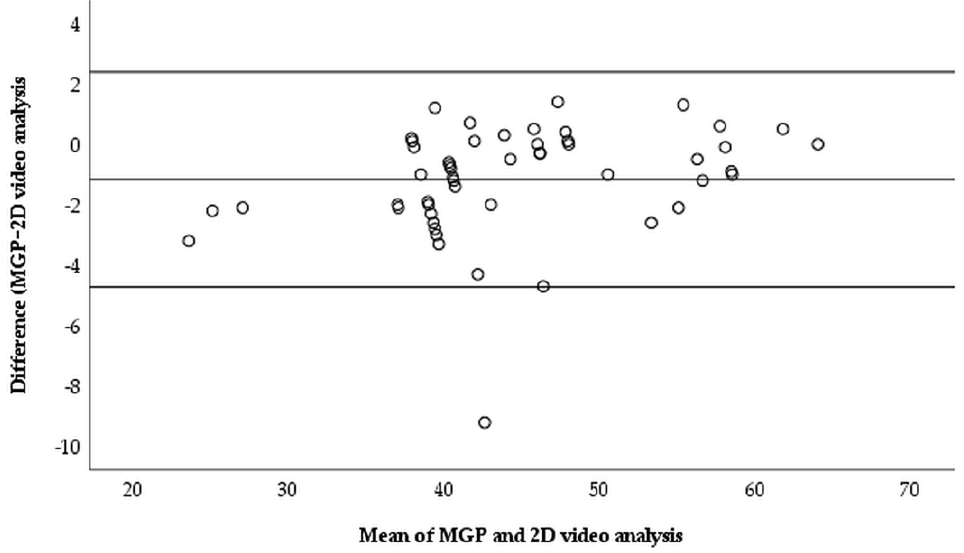
Figure 3. The modified goniometric platform and video analysis measurement for right trunk rotation.